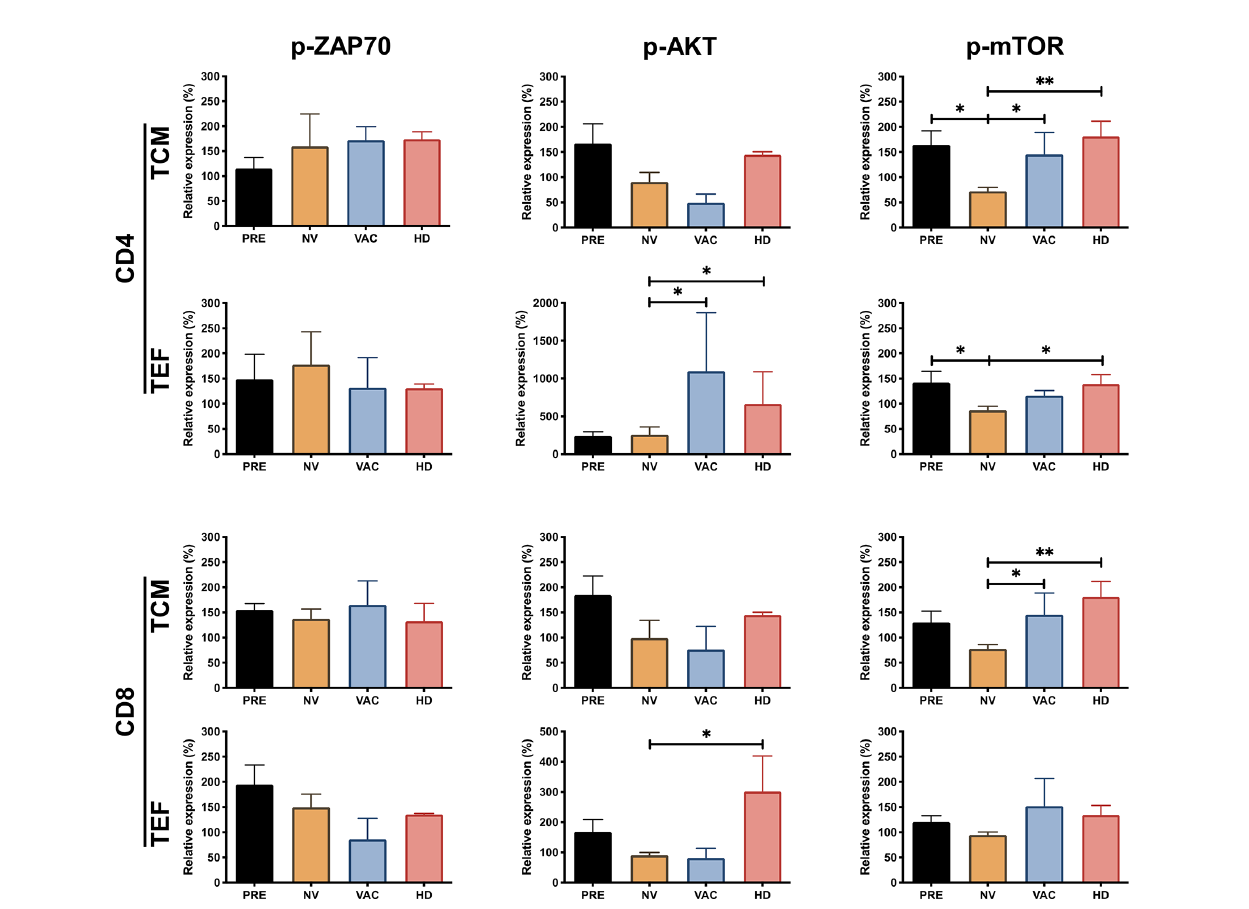
FIGURE 3 | NAC plus dendritic cell (DC) therapy restores T-cell function re fl ected by the increasing phosphorylation of ZAP70, AKT, and mammalian target of rapamycin (mTOR). Relative expression of p-ZAP70, p-AKT, and p-mTOR in CD4+ and CD8+ T cells, central memory T cells (TCM), and terminal effector T cells (TEF). The expression was normalized based on the median fl uorescent intensity (MFI) of each molecule in non-stimulated peripheral blood mononuclear cells (PBMCs) over stimulated cells (represented over 100%) in the four groups, patients before chemotherapy (PRE, black bars), post-chemotherapy alone [non- vaccinated (NV), yellow bars], vaccinated patients (VAC, blue bars), and healthy donors (HDs, red bars). Non-parametric Mann – Whitney test between populations or groups. *p < 0.05, **p <